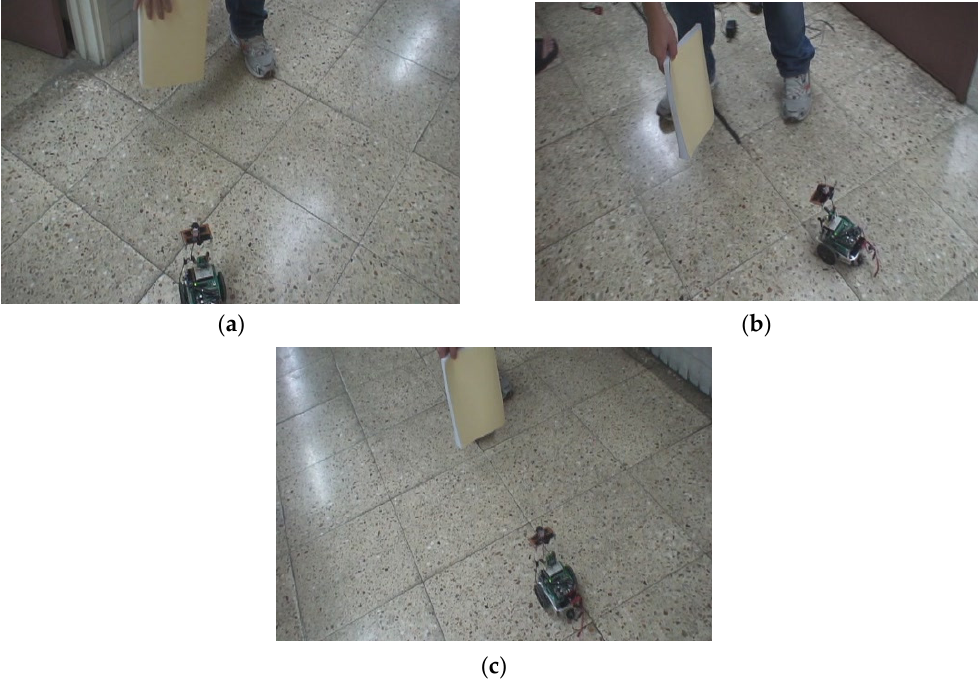
Figure 23. Dynamic tracking operation. ( a ) Starting tracking operation; ( b ) Tracking position 1; ( c ) Tracking position 2.